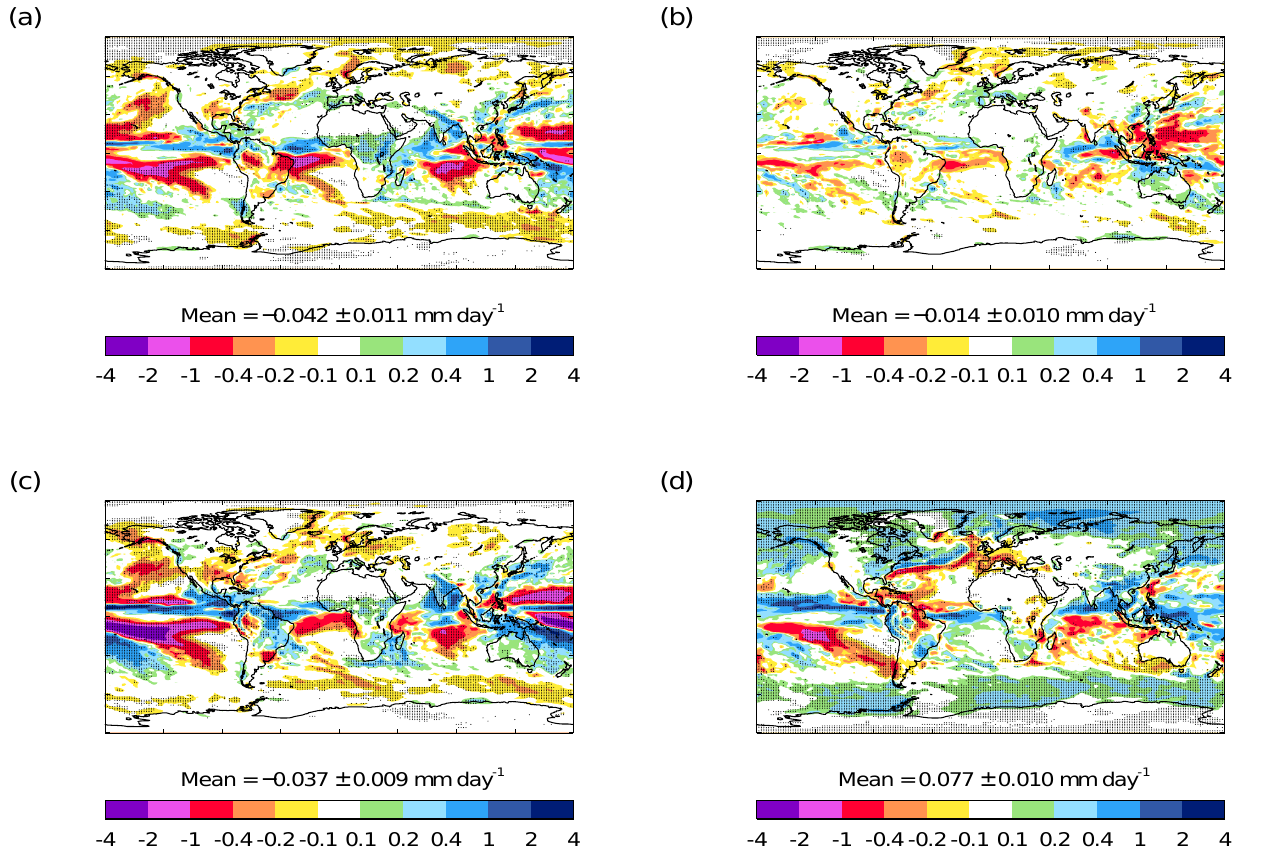
Fig. 6. (a) Mean 2040-2069 change in precipitation rate (mmday − 1 ) with respect to the same period in RCP4.5 when using the I-mask emission pattern for geoengineered sea-spray. (b) As (a) but using the D-mask emission pattern. (c) As (a) but using I-mask NSA . (d) Change in precipitation rate in RCP4.5 between 1990–2019 and 2040–2069. Areas where changes are significant at the 5% level are